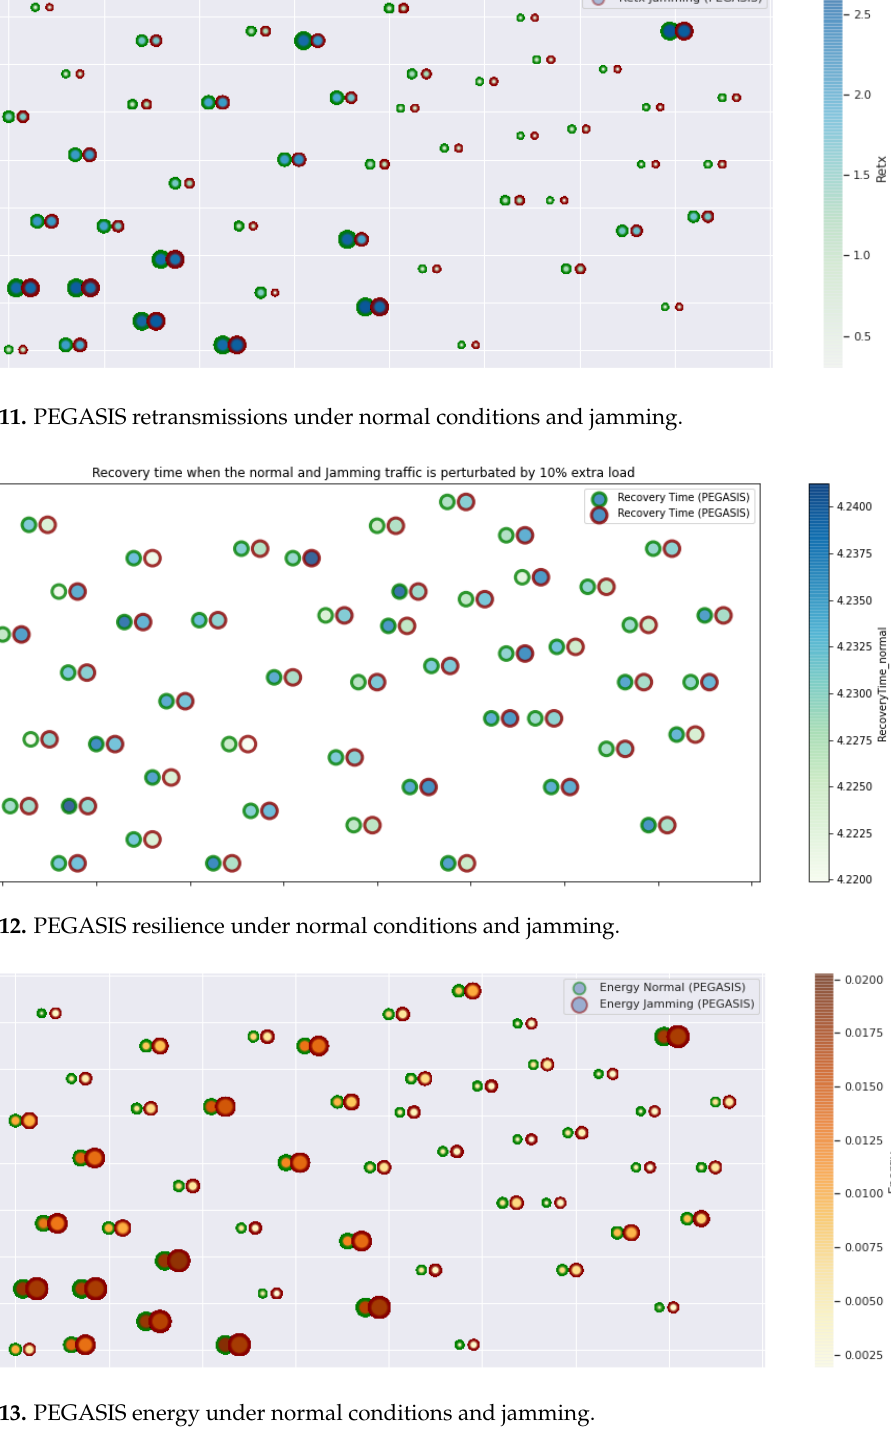
Figure 13. PEGASIS energy under normal conditions and